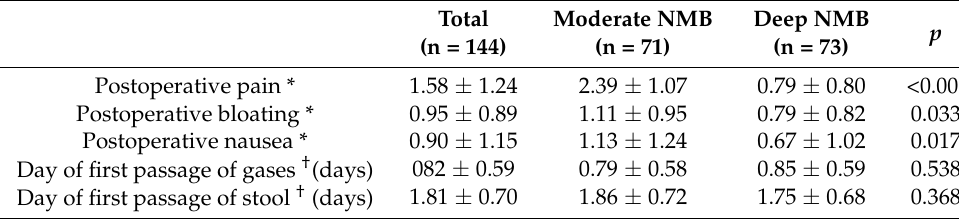
Table 4. Patient rating of postoperative symptoms and postoperative bowel function.